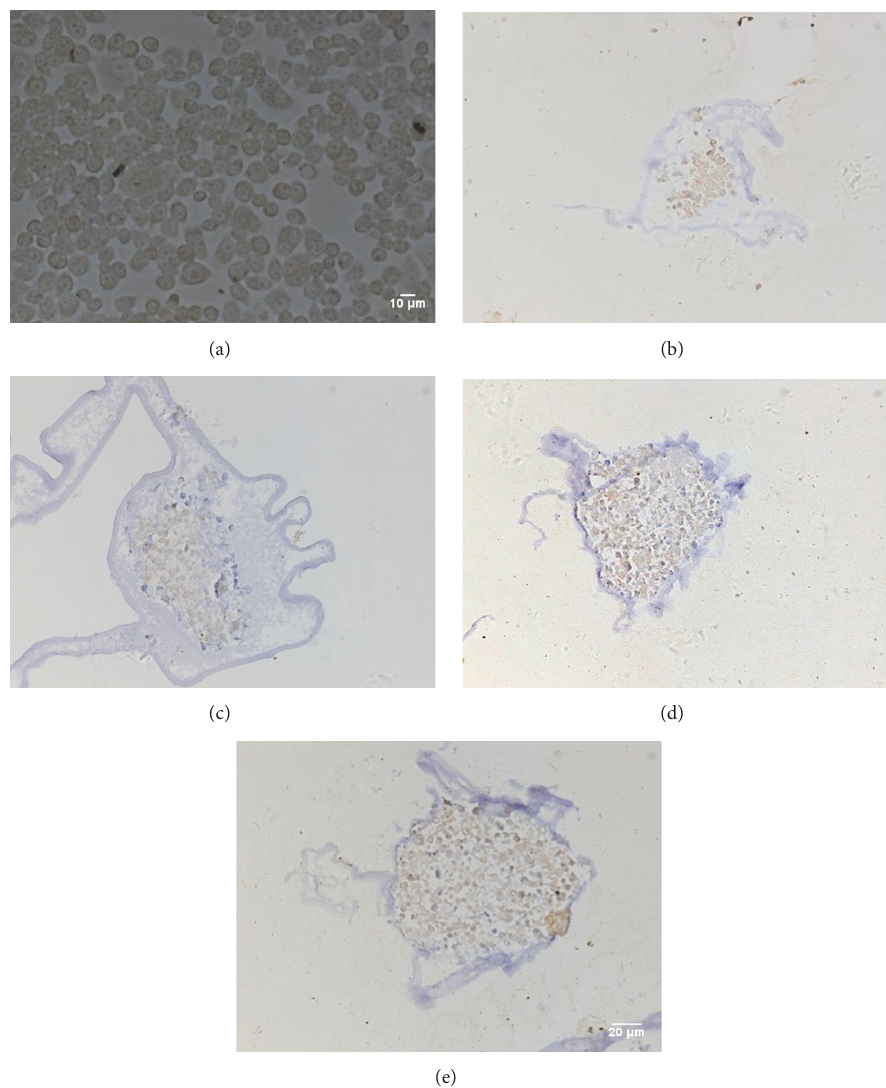
Figure 7: Expression of VEGF in the cells and spheres by H&E staining. Brown nuclei indicated positive VEGF staining. (a) Monolayer SGC9701 cells showed positive VEGF expression. (b, c, d) The microencapsulated cell spheres cultured for 7, 14, and 21 days: VEGF expression was observed throughout the entire spheres. (e) The microencapsulated cell spheres cocultured with macrophages for 3 days: the number and density of the spheres expressing VEGF were increased. Magnification: